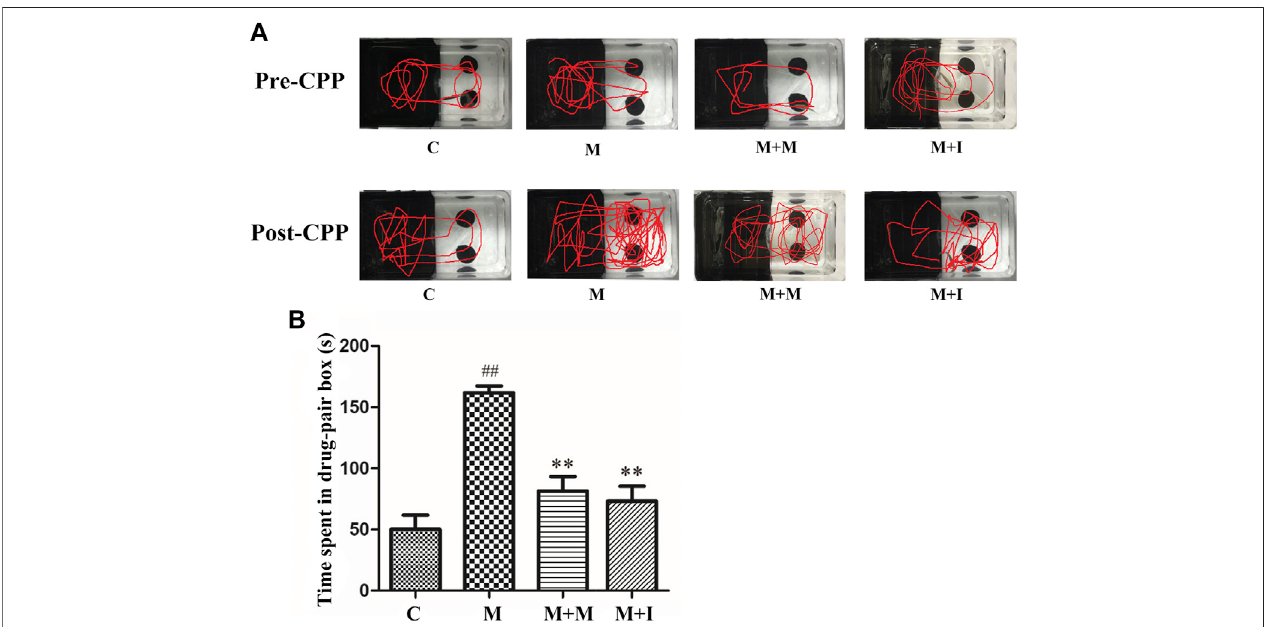
FIGURE 4 | Isorhynchophylline can inhibit morphine-induced CPP responses. (A) Road maps of zebra fi sh in the CPP compartment. (B) Time spent in the drug- paired box post-CPP ( n (cid:2) 8). * p < 0.05, ** p < 0.01 vs the C group; # p < 0.05, ## p < 0.01 vs the M group. C: control group; M: morphine group; M + M: morphine + methadone group; M + I: morphine + isorhynchophylline